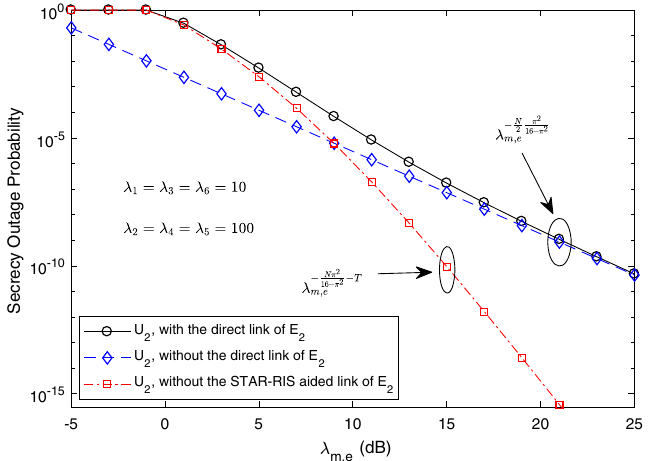
Fig. 10 The theoretical results of SOP for user U 2 versus (cid:31) m , e . When the transmission power is constant, The impact of the (cid:31) m , e on the SOP for user U